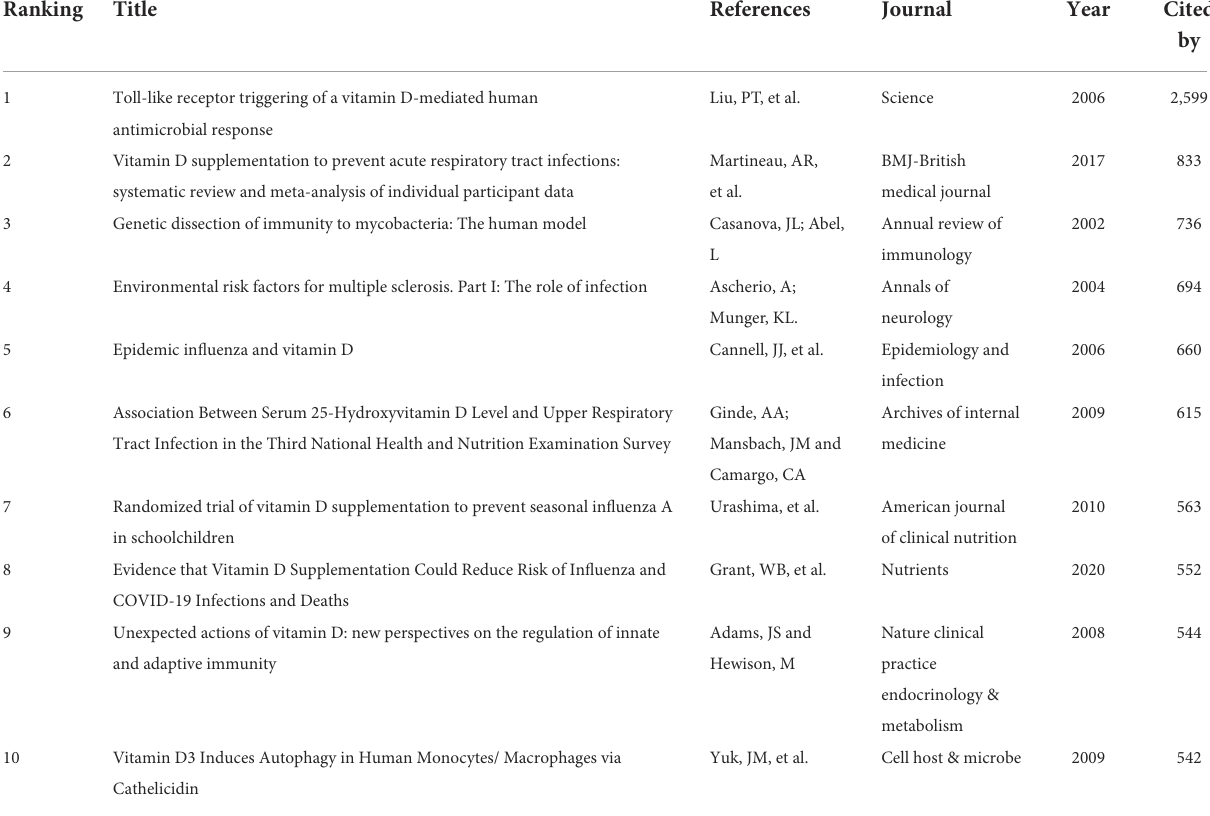
TABLE 2 Top 10 high-cited references related to vitamin D and infections.